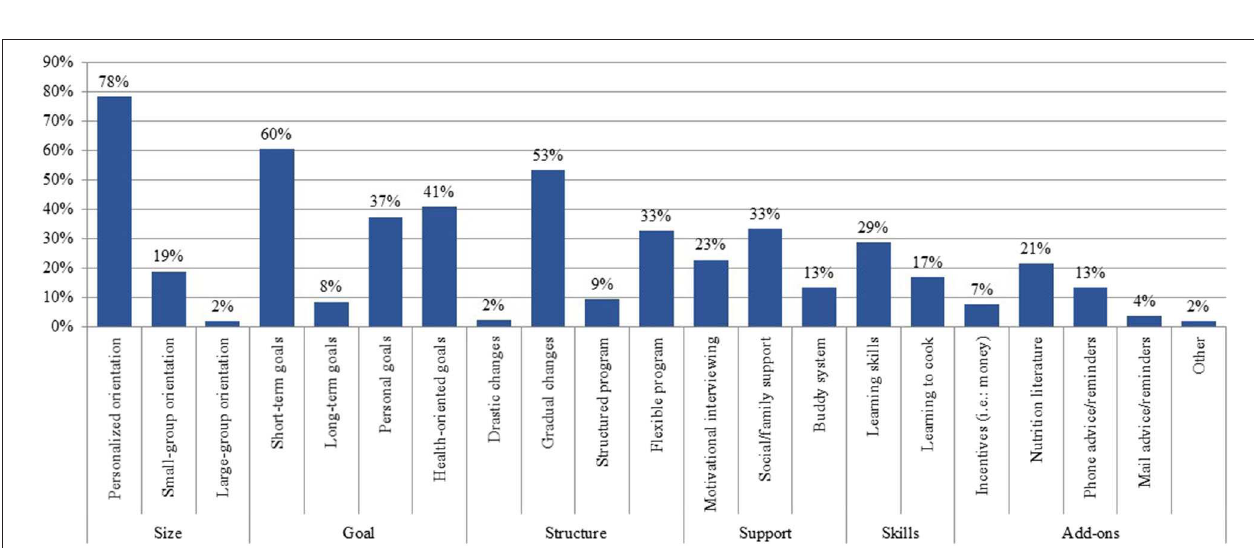
FIGURE 2 | Strategies perceived by nutrition professionals as effective for behavioral change toward healthy eating. Shown as percentage from 414 nutrition professionals surveyed in Puerto Rico that perceive a strategy as effective for behavioral change toward healthy eating. Strategies were combined into general themes: size, goals, structure, support, skills, and